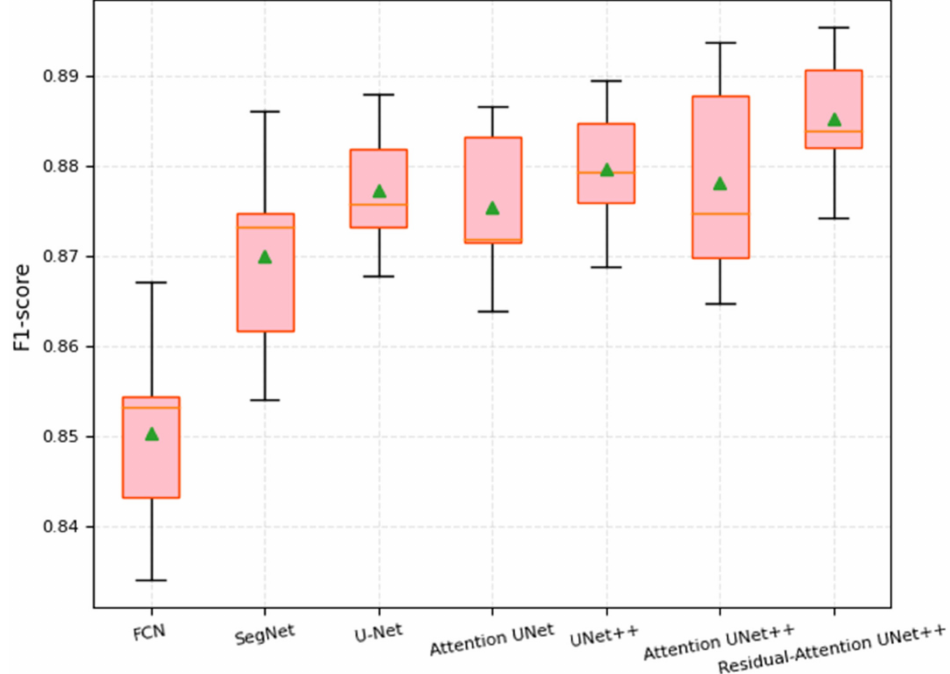
Figure 12. The comparison between Residual-Attention UNet++ and other methods on F1-score after multiple experiments for skin